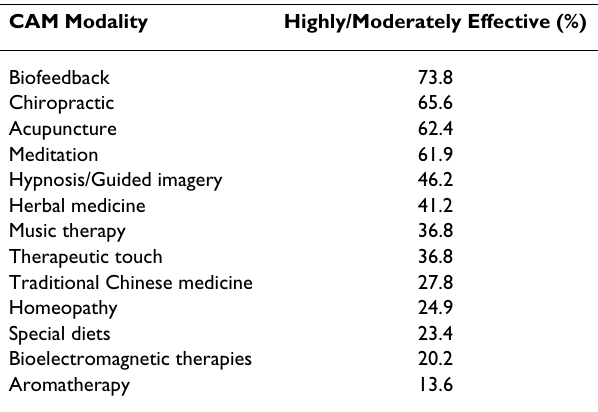
Table 2: Physician opinion of effectiveness of CAM